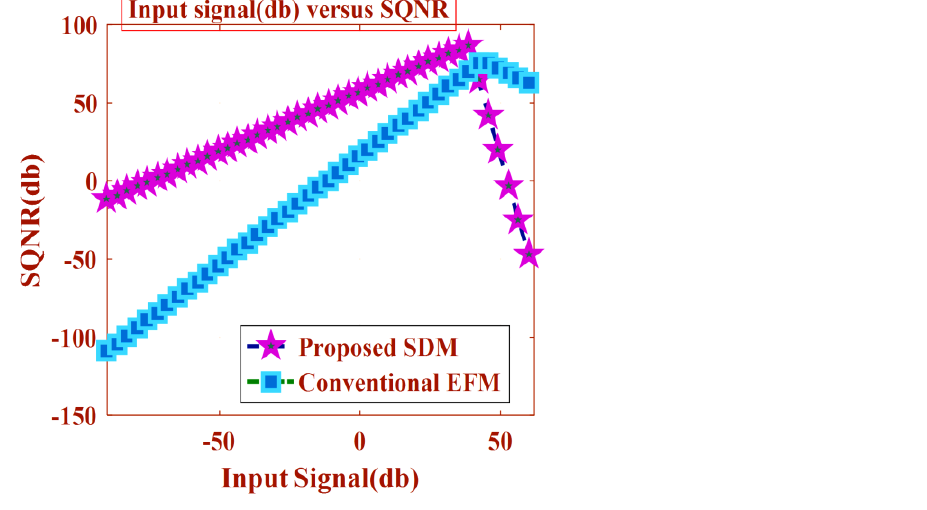
Figure 15. SQNR vs. Input signal.